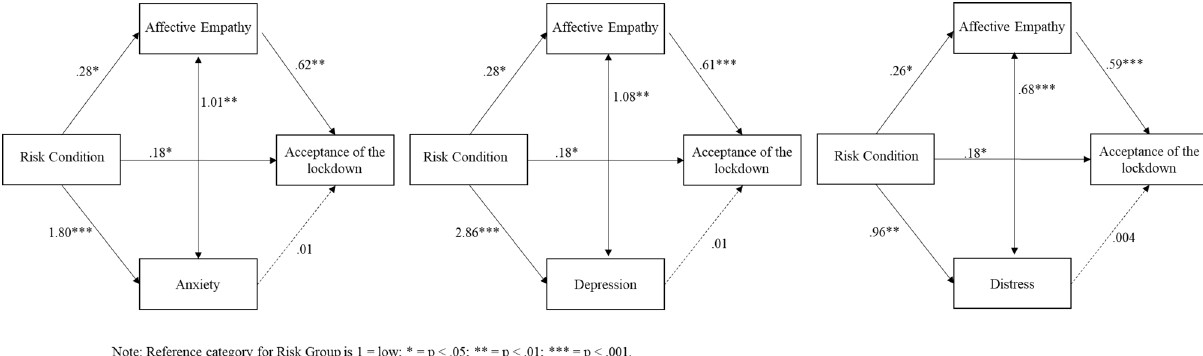
Figure 3. The models tested, Phase